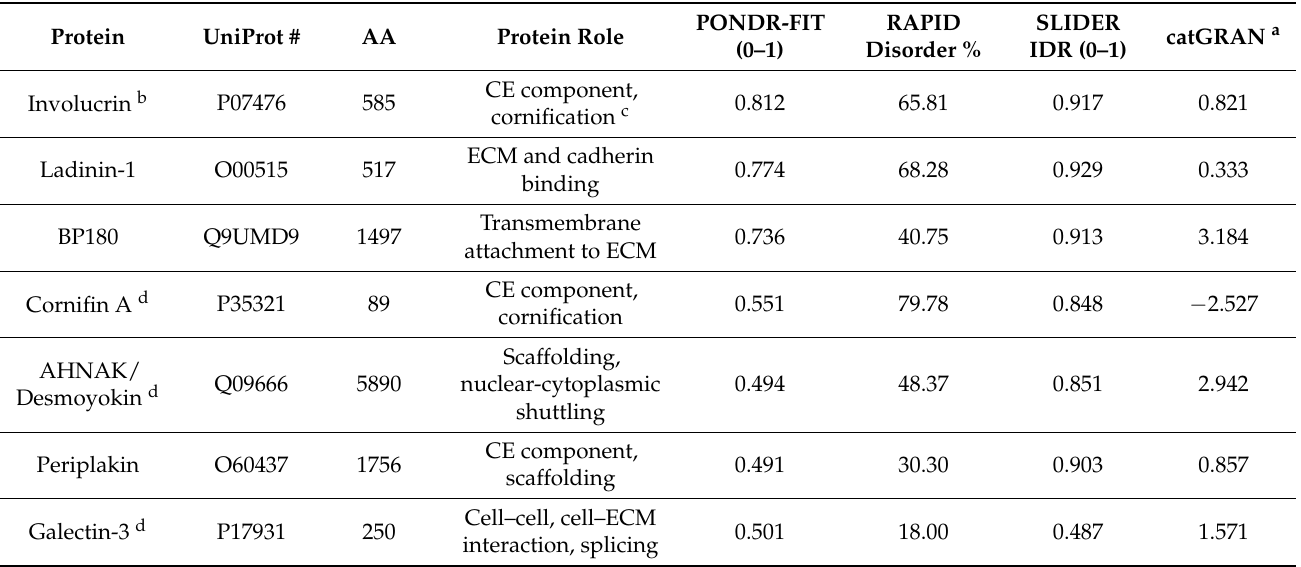
Table 1. Computational analysis for a subset of thermostable proteins specific to or highly expressed in HaCaT epidermal keratinocytes (see also Figure